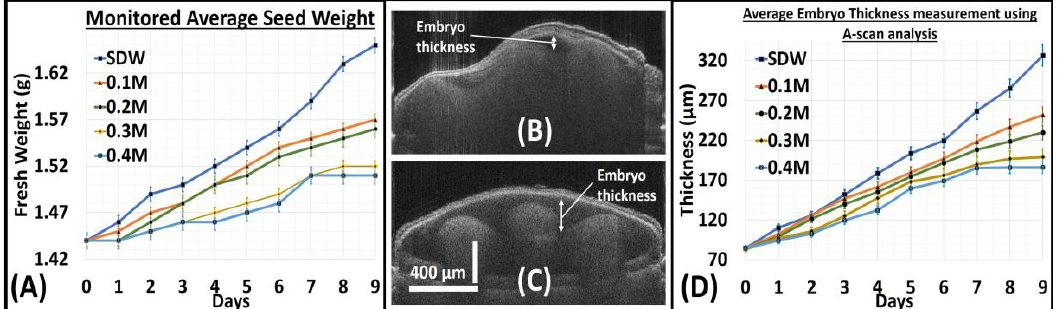
Figure 4. Statistical analysis of 2D OCT images using depth profile analysis. ( A ) The recorded average seed weight fluctuations during monitoring period. ( B , C ) Representative 2D-OCT images marked with embryo region in a seed. ( D ) The measured average embryo thickness using depth profile analysis of all seed groups during the monitoring period.